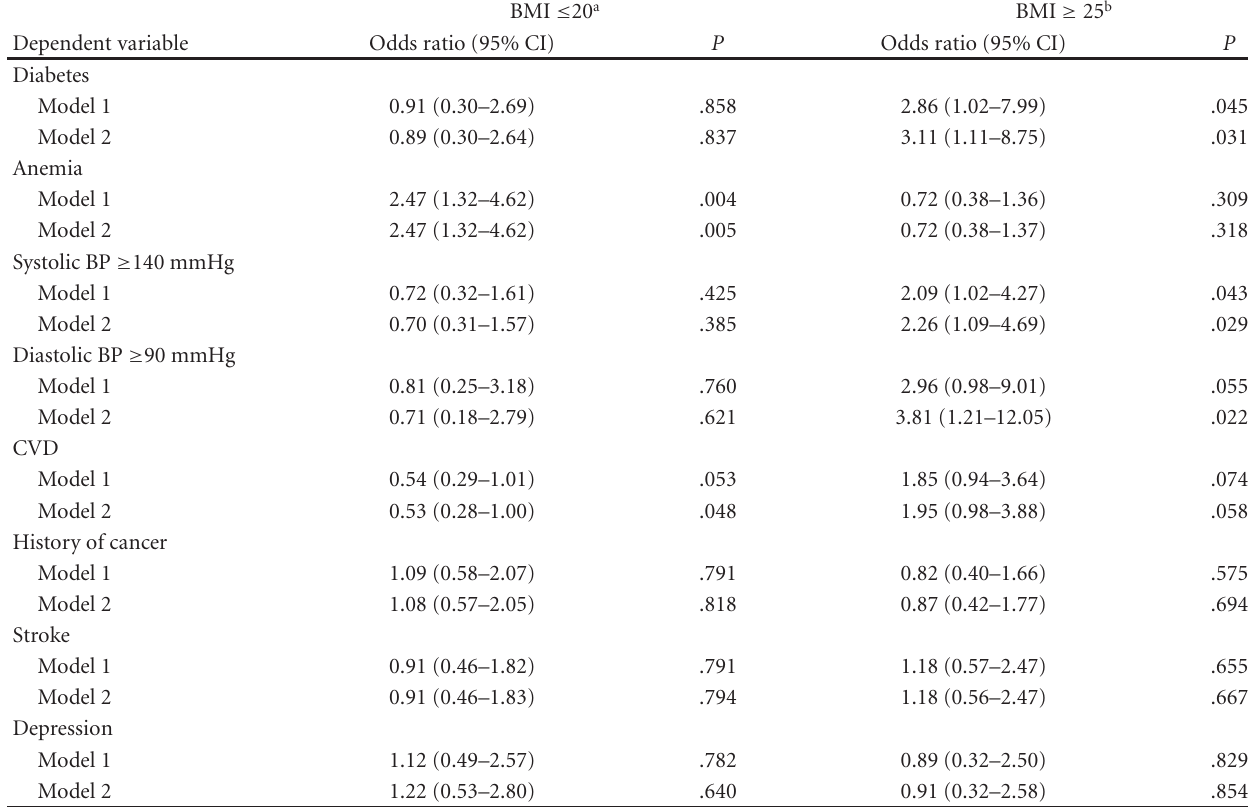
Table 4: Associations of underweight or overweight/obesity with health conditions or indicators in Georgia